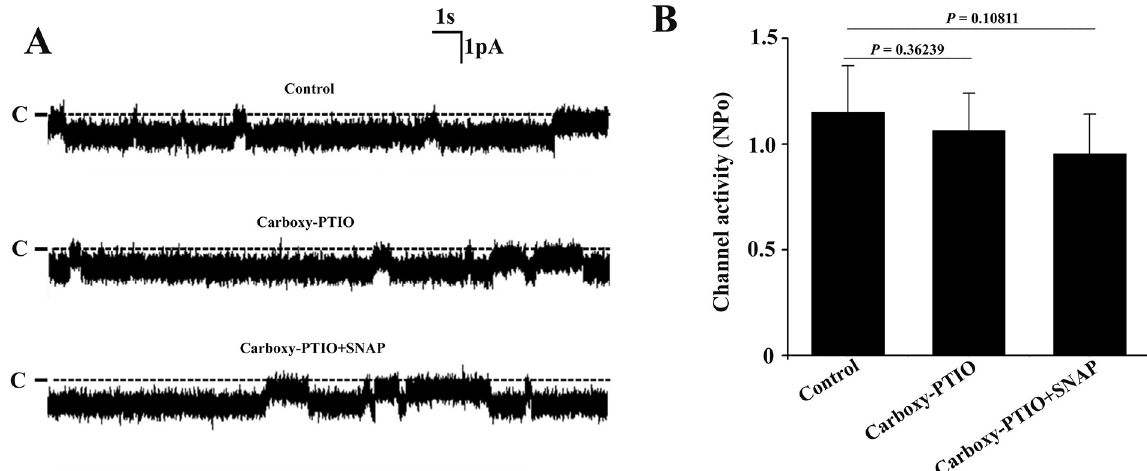
Fig 2. Scavenging NO diminishes the inhibitory effect of SNAP on the 10-pS Cl - channels. (A) A set of singe channel recordings from the same patch in a cell-attached patch under control condition, in the presence of 10 μ M carboxy-PTIO alone as well as in the presence of 10 μ M carboxy-PTIO + 5 μ M SNAP. The holding potential was − 60 mV and the channel closed level is indicated by the dotted line and “C”. (B) Statistical summary showing that carboxy-PTIO abolishes the inhibitory effect of SNAP on the channels (n = 6).